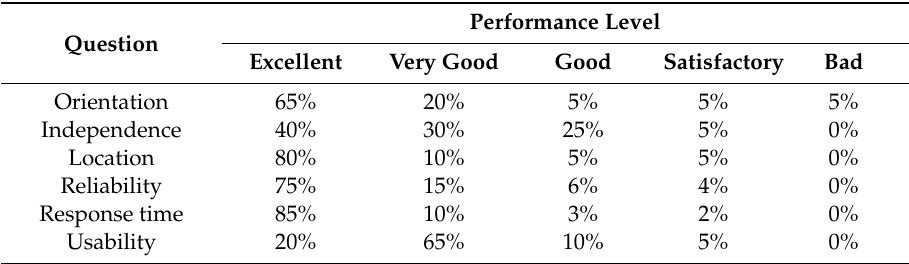
Table 7. Results of questions after experiments.